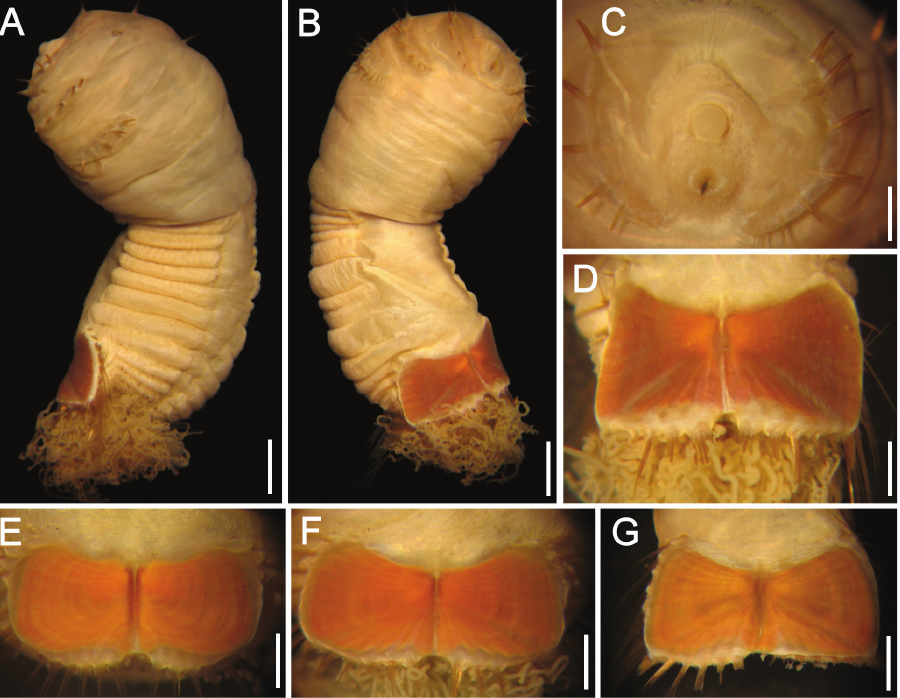
Figure 7. Sternaspis uschakovi sp. n. A Holotype (ZIRAS 50604), lateral view B Oblique ventral view C Anterior end, frontal view D Ventro-caudal shield, frontal view E – F Paratypes, ventro-caudal shields, frontal view G Non-type specimen (ZIRAS 50606), ventro-caudal shield, frontal view. Bars: A 1.7